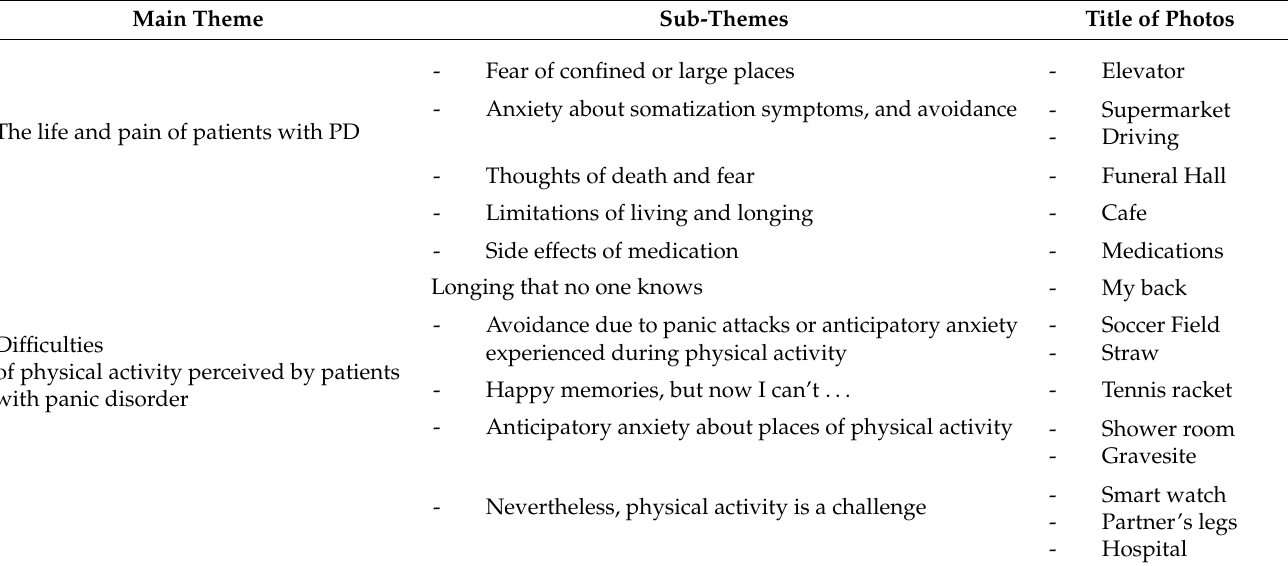
Table 3. Presentation of the obtained